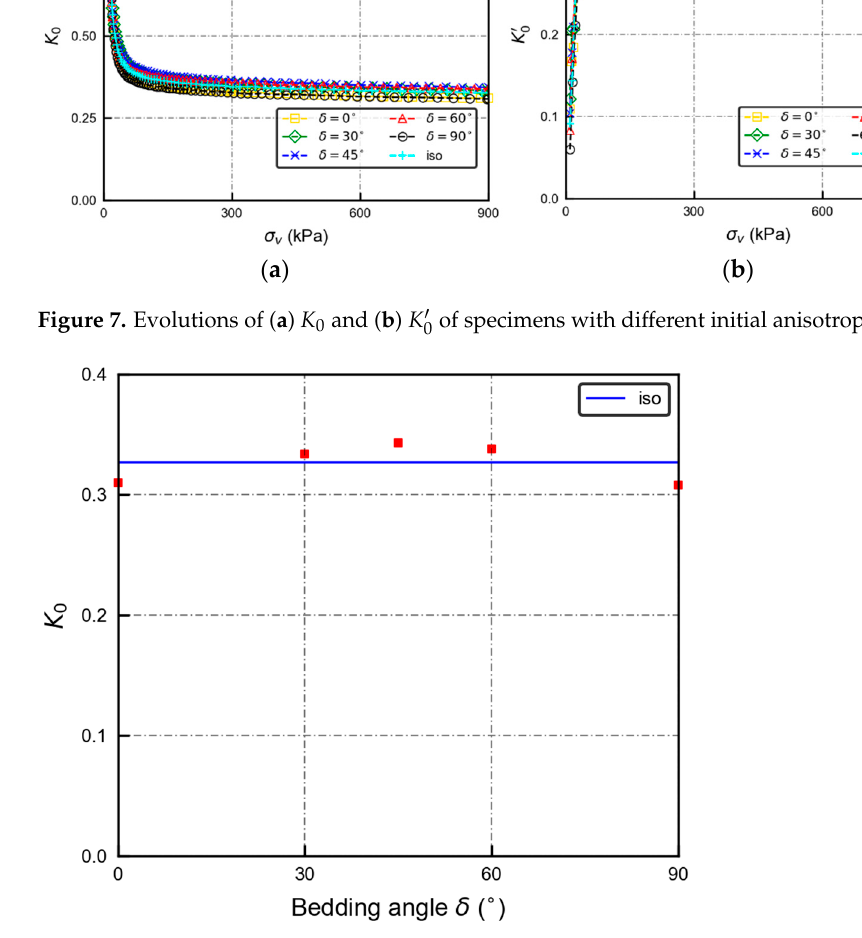
Figure 8. K 0 value vary with initial anisotropy.